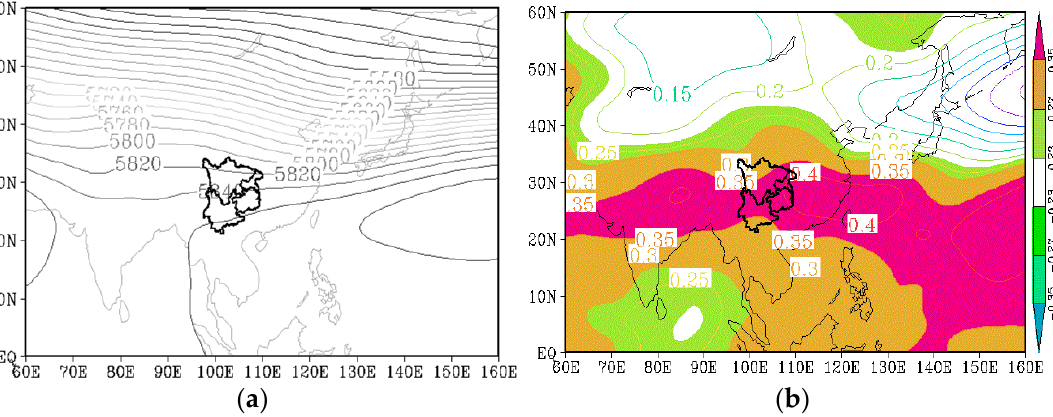
Figure 9. The 500 hPa height field of rainstorms and floods in high-value years ( a ), the correlation coefficient ( b ) of rainstorms and floods, and 500 hPa height field in the summer half-year during 1961 – 2021. The shaded areas represent those where the correlation passes 90% (Green), 95% (Brown), and 99% (Rose) significance levels.